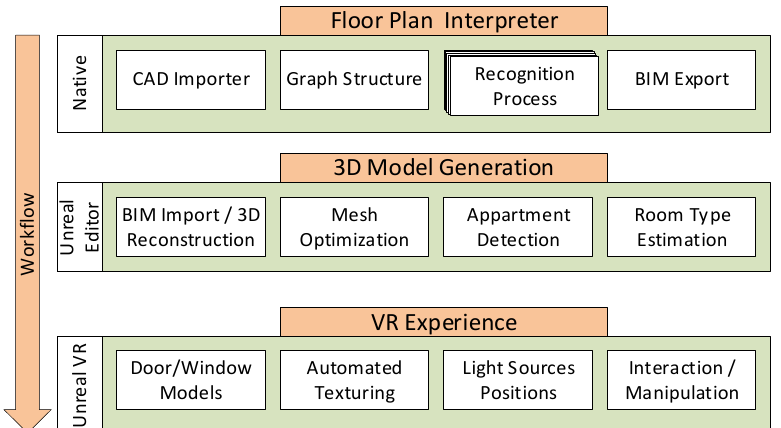
Figure 1. System overview of the three main modules. Native C++ implementation is used mainly for symbol detection, the Unreal editor adjustments were utilized for 3D model generation and finally, the virtual reality (VR) experience module in Unreal Engine is employed for VR visualization.